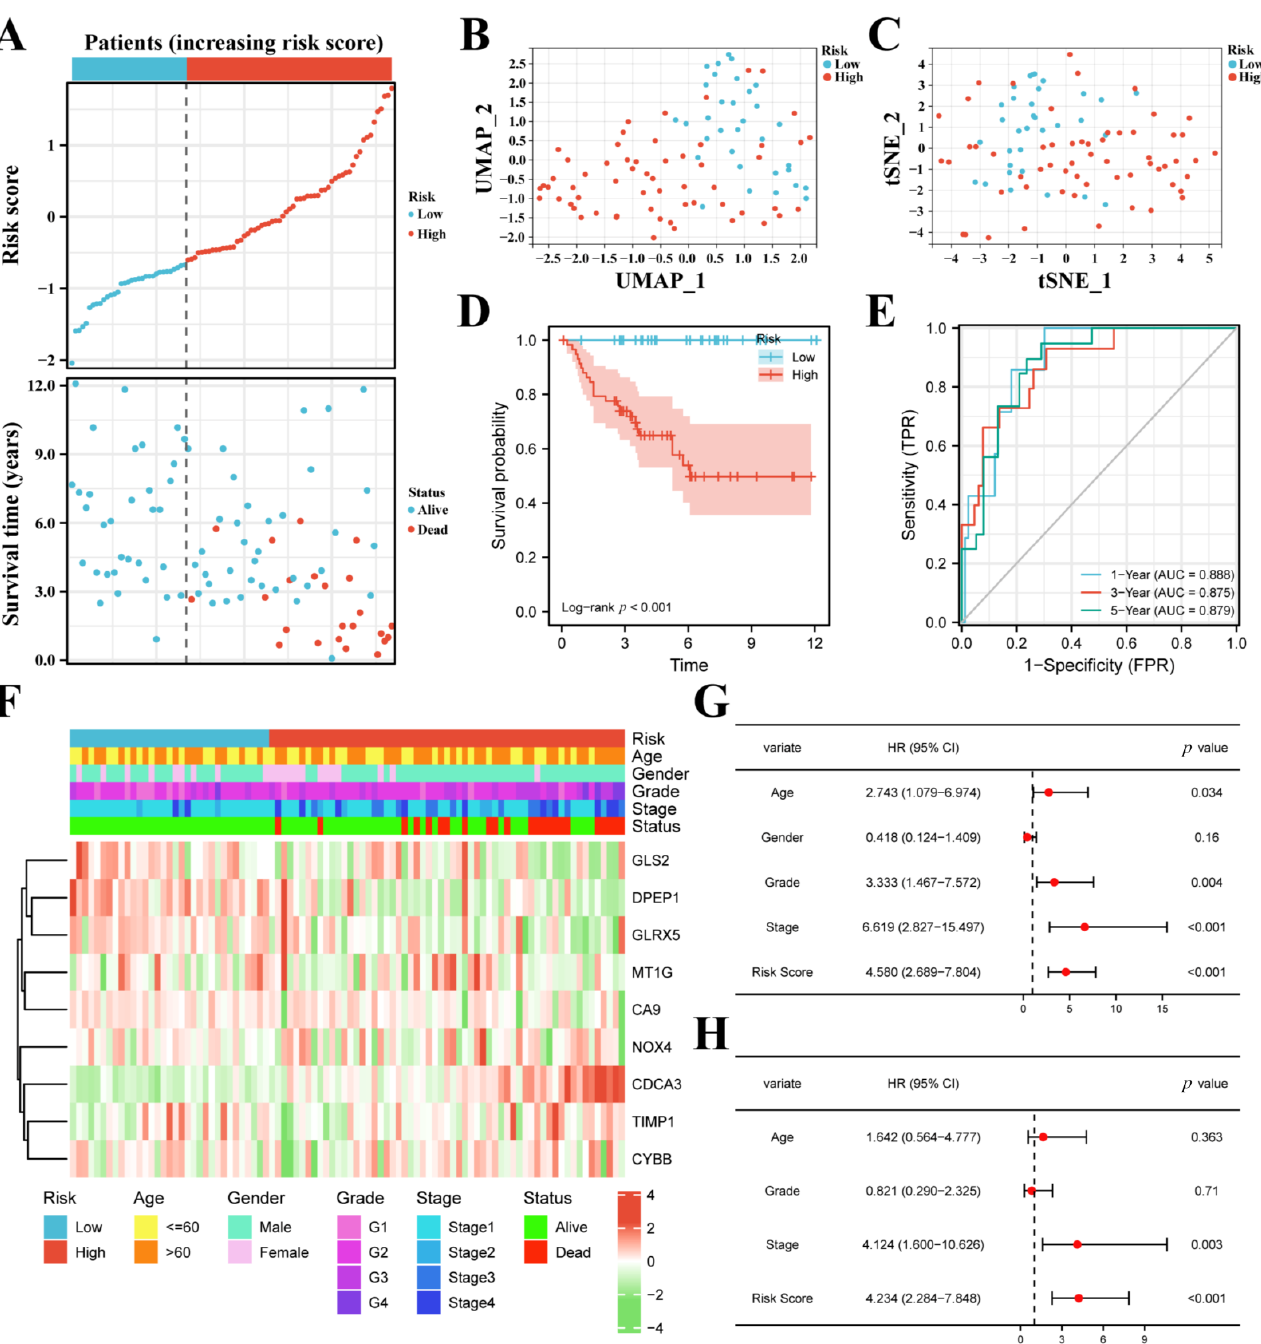
Figure 5. Validation of the FPM in E-MTAB-1980 cohort. ( A ) Distributions and media value of ccRCC patients with increasing risk score and distribution of ccRCC patients with corresponding survival status. ( B ) UMAP plot of the ccRCC patients showing the distribution in two risk groups. ( C ) t-SNE plot of the ccRCC patients showing the distribution in two risk groups. ( D ) K–M curves of patients in two risk groups. ( E ) AUC of the time-dependent ROC curves showing the prognostic value of the risk score. ( F ) Heatmap showing the correlations between risk groups and clinical characteristics. ( G ) Univariate Cox regression analysis of the factors. ( H ) Multivariate Cox regression analysis of the factors.